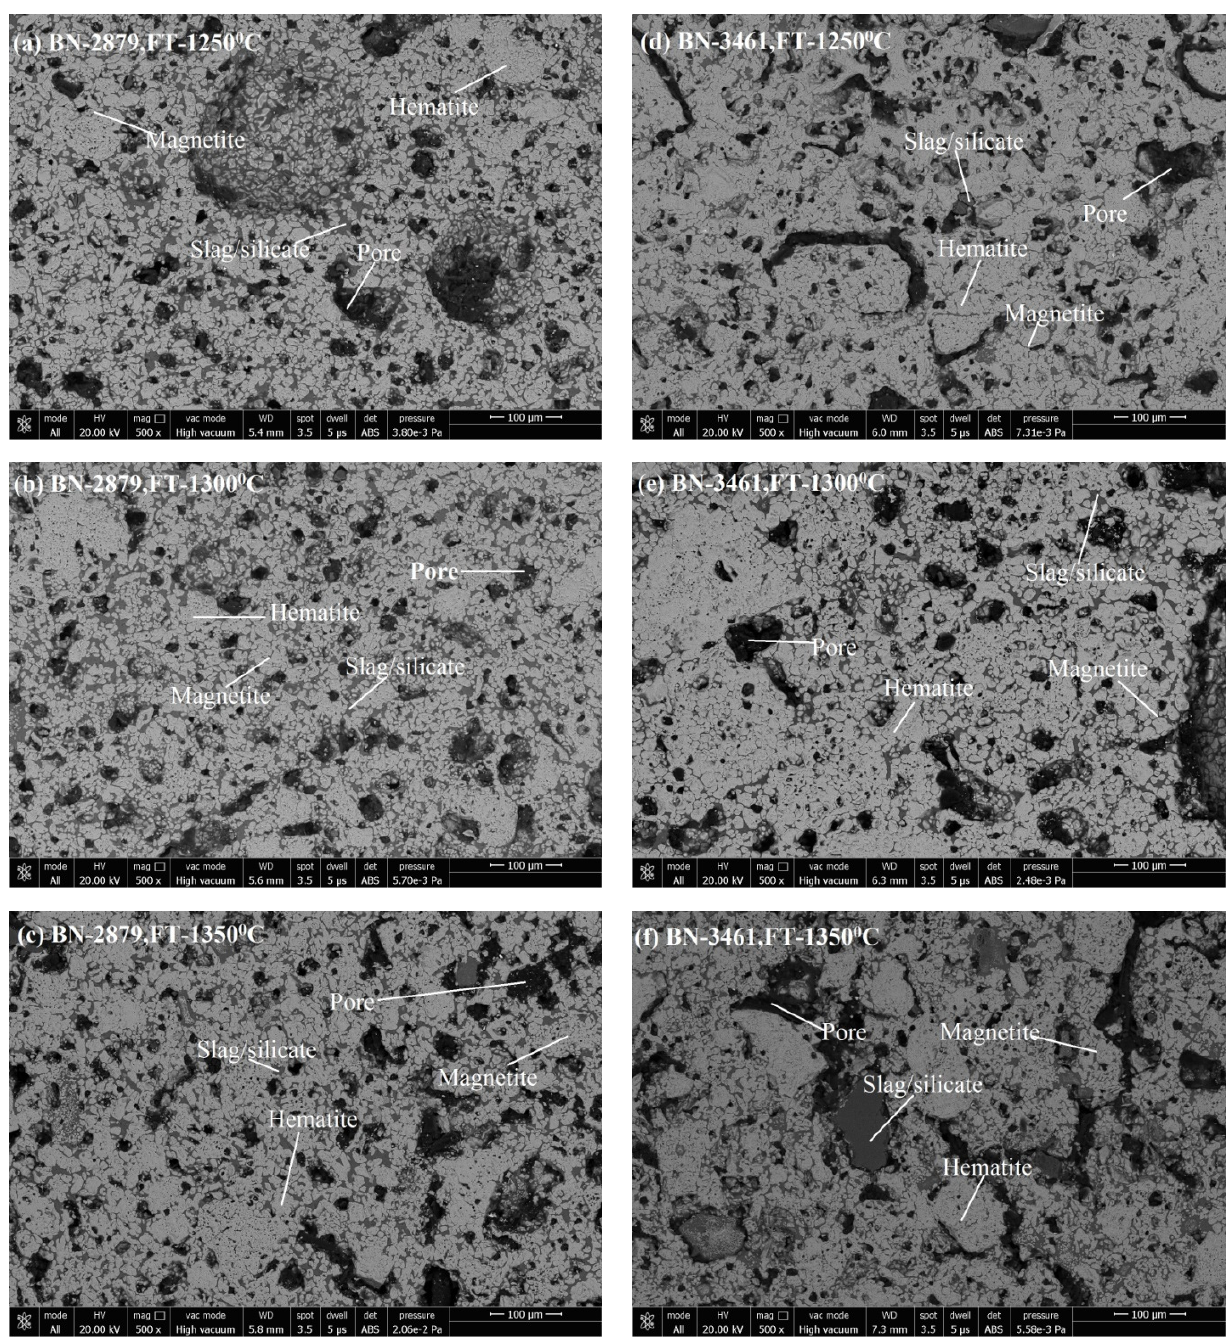
Figure 8. SEM Microstructure of ( a ) M3A, ( b ) M3B, ( c ) M3C, ( d ) M4A, ( e ) M4B, and ( f ) M4C pel- lets.